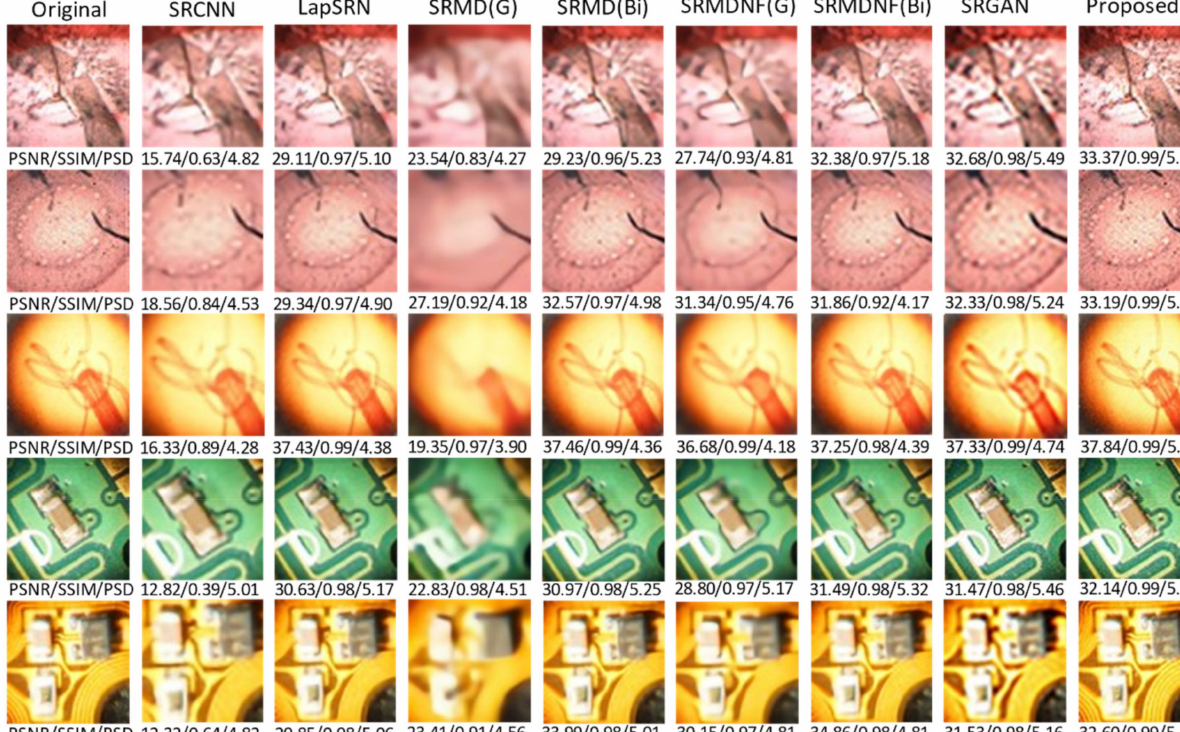
Figure 8. × 2 upscaling comparison. The SRCNN, LapSRN, SRMD, SRMDNF, and SRGAN algorithms are compared with the proposed method. Most of the cases, the proposed method performs better than others, and the super-resolved image is almost indistinguishable from the